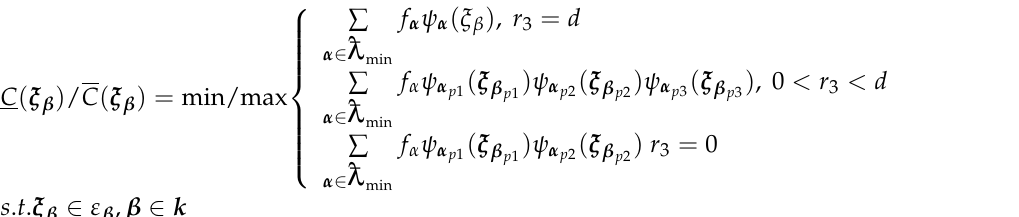
Figure 2. Framework of the SSR-ETM and ETM.